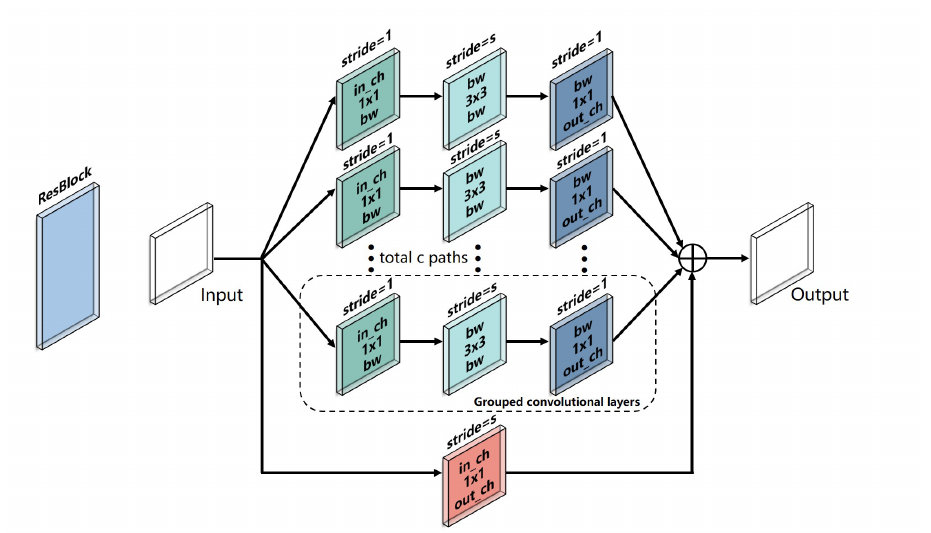
Figure 8. Schematic diagram of the CNN backbone.